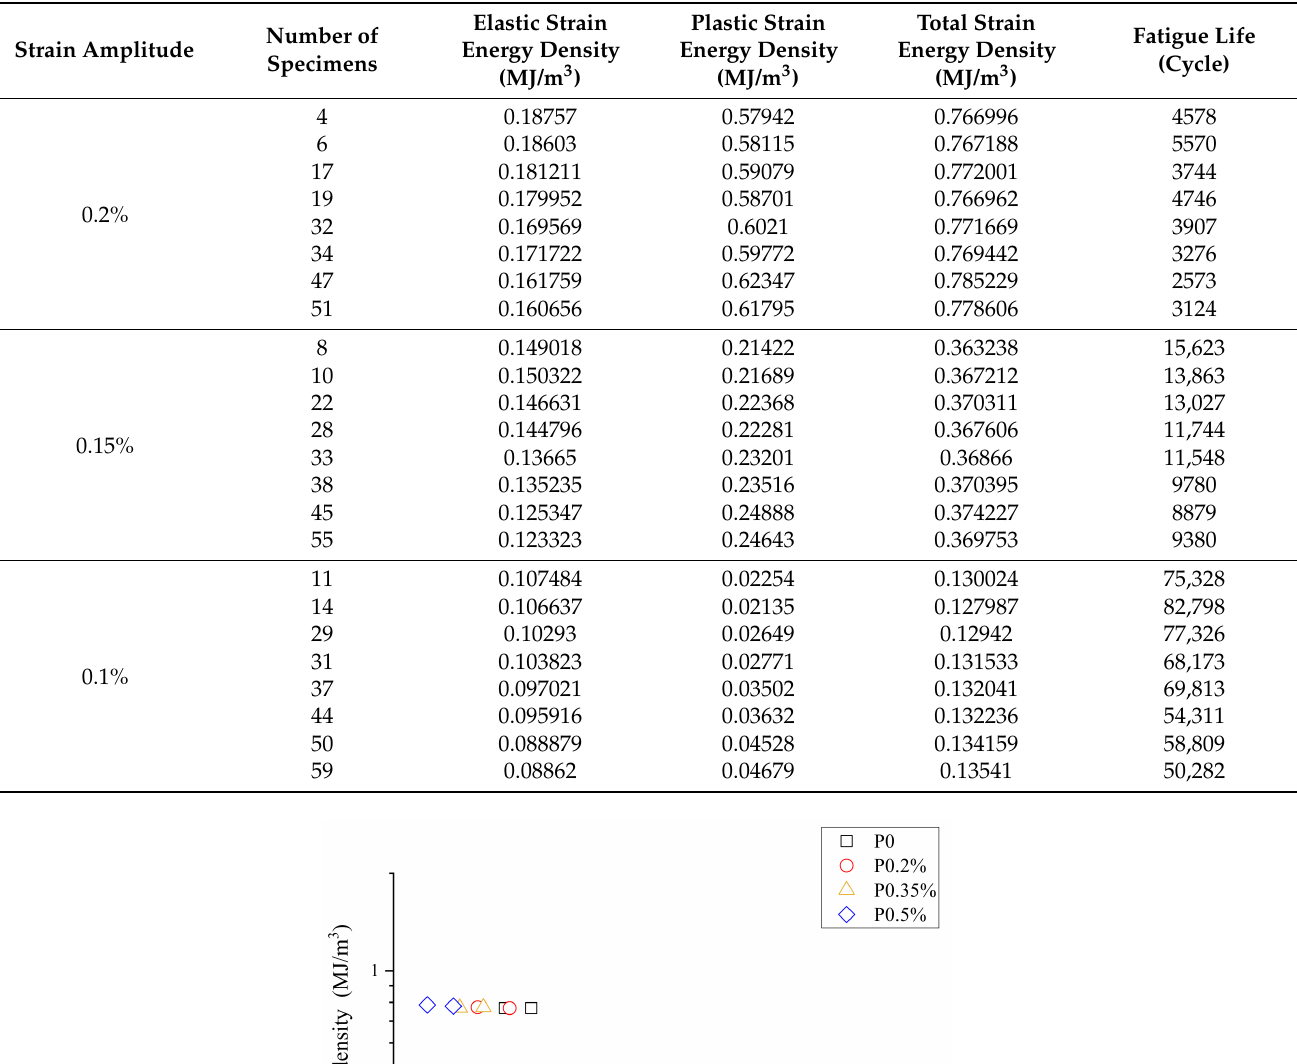
Table 3. Strain energy density value versus fatigue life.